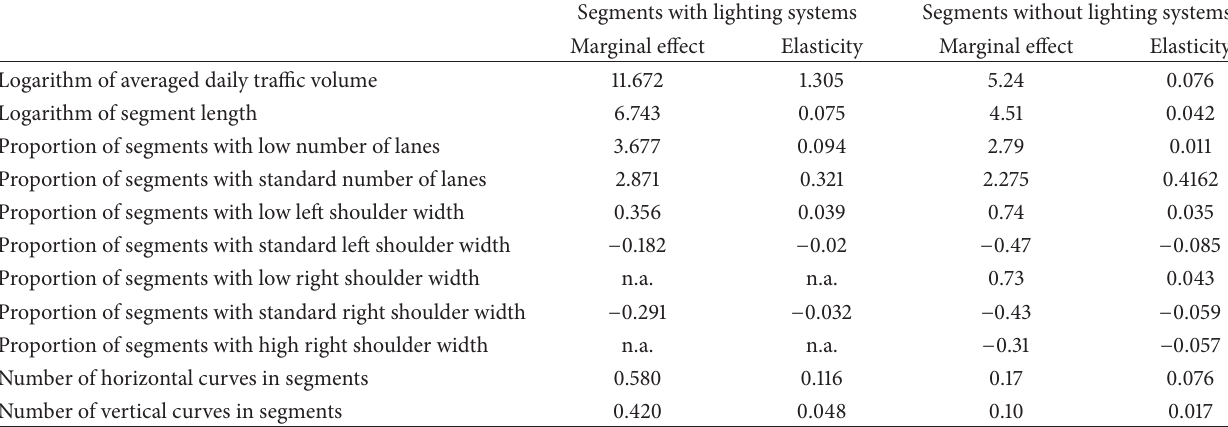
Table 5: Average marginal effects and elasticities for random parameters negative binomial